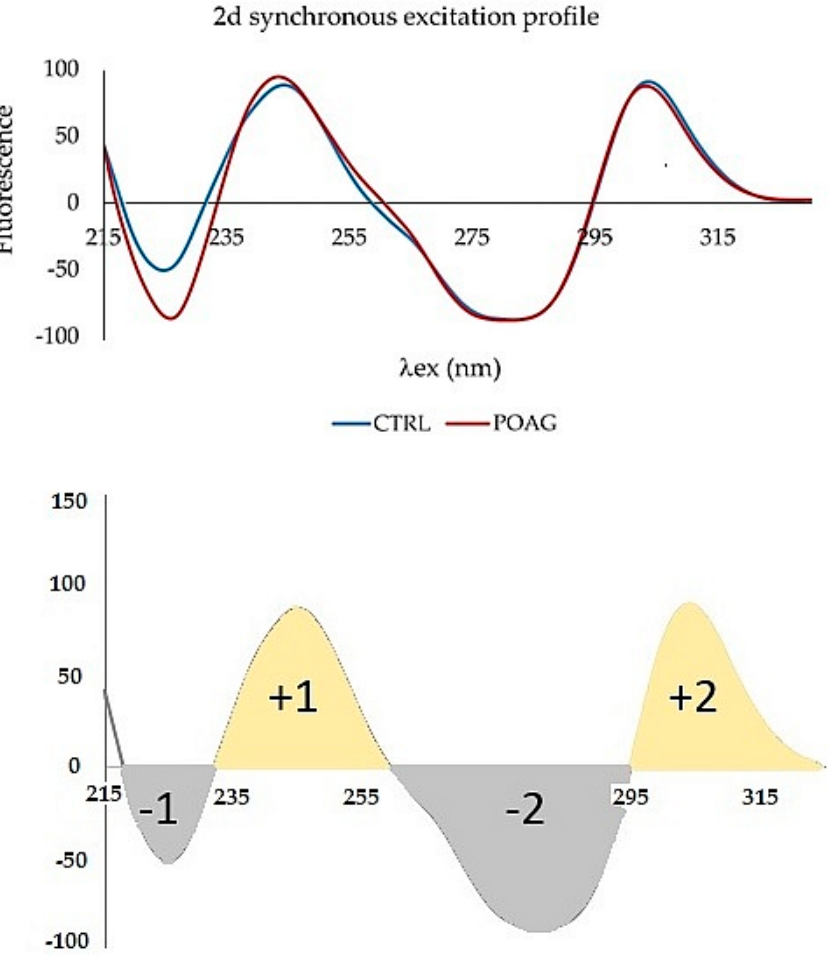
Figure 5. Upper graph: The second derivative of the synchronous spectrum of tear fluid of control group (CTRL) and patients with glaucoma (POAG). The spectra represent the average of the groups. Bottom graph: Zones of the second derivative of the synchronous spectrum. These were used to process the spectra of tear fluid. Mathematical processing was done to build plot in Figure 6.